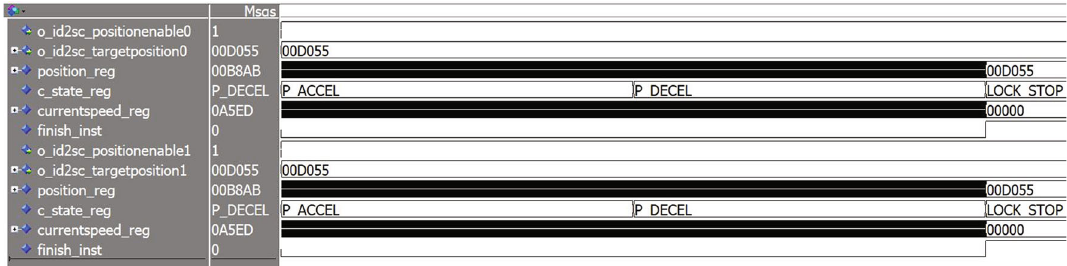
Figure 8: Simulation waveform of 15 ° angle